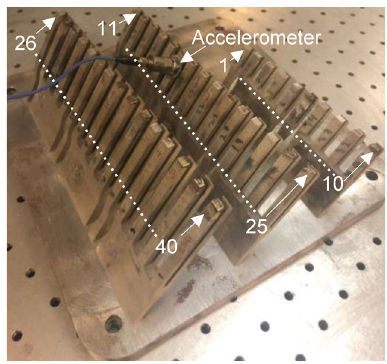
Figure 2. Tuning fork build with arrows indicating beginning and ending tuning forks for each row, where the tuning fork numbers linearly increment. The tuning forks that were used in experiments are tabulated in Table 1 in “Methods”.